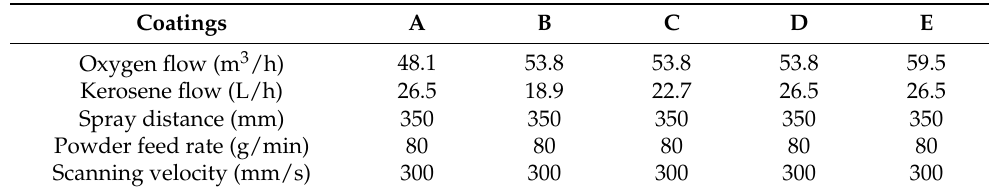
Table 1. Detailed spraying parameters of Fe-based